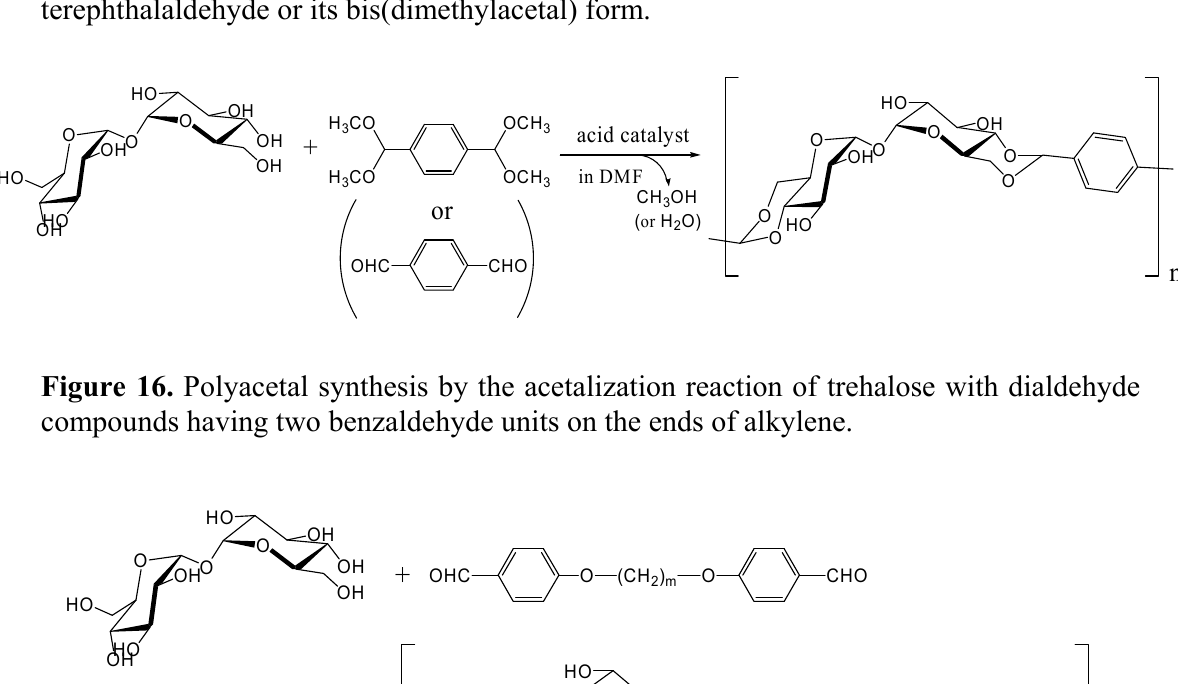
Figure 15. Polyacetal synthesis by the acetalization reaction of trehalose with terephthalaldehyde or its bis(dimethylacetal) form.